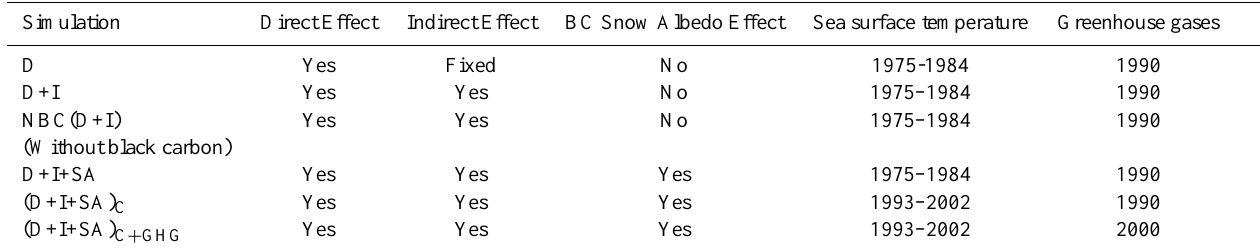
Table 1. Description of simulations used for the study. All simulations are performed with the Beig and Bond emissions separately, unless indicated